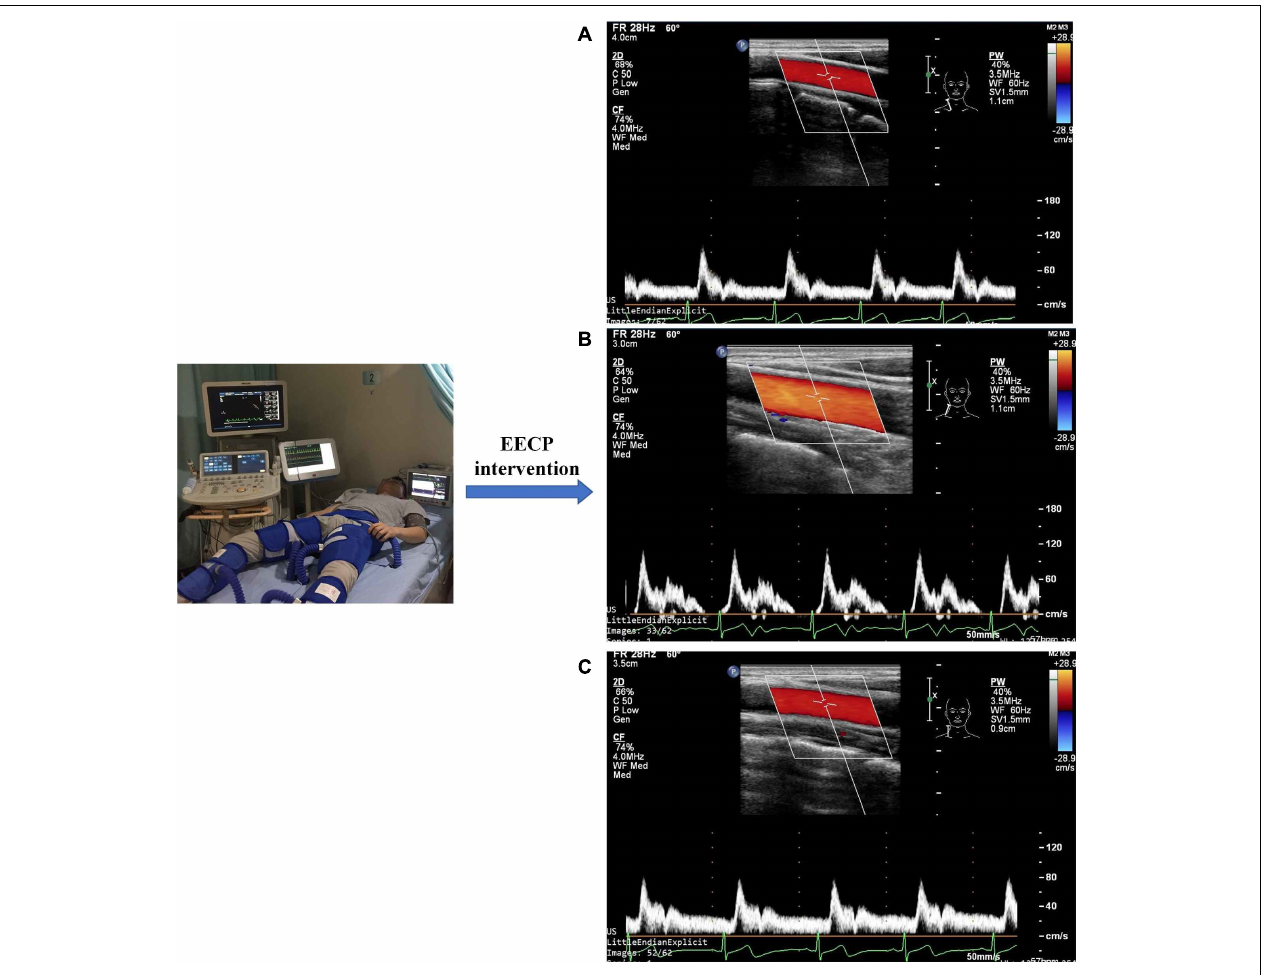
FIGURE 1 | Measurement of blood flow velocity spectrum in the right common carotid artery before (A) , during (B) , and immediately after EECP (C) .